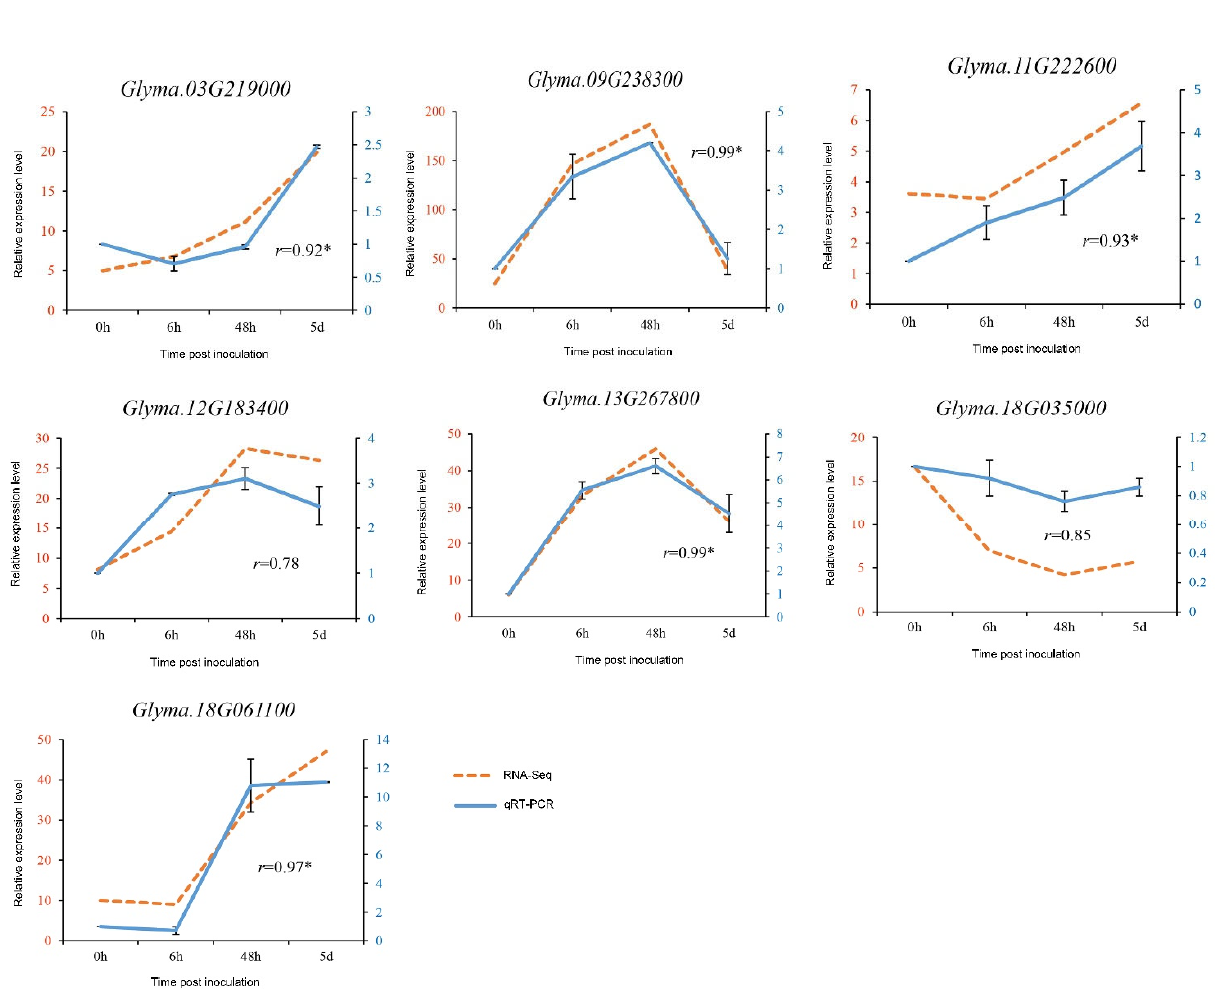
Figure 6. Comparison of the relative expression level change of 7 selected DEGs by qRT ‐ PCR and RNA ‐ Seq (resistant variety Kefeng ‐ 1, left vertical axis coordinate is FPKM of RNA ‐ Seq (orange); right vertical axis coordinate is relative expression level of qRT ‐ PCR (blue); r ‐ values are the correlation coefficients between qRT ‐ PCR and RNA ‐ seq, * indicates significant correlation.